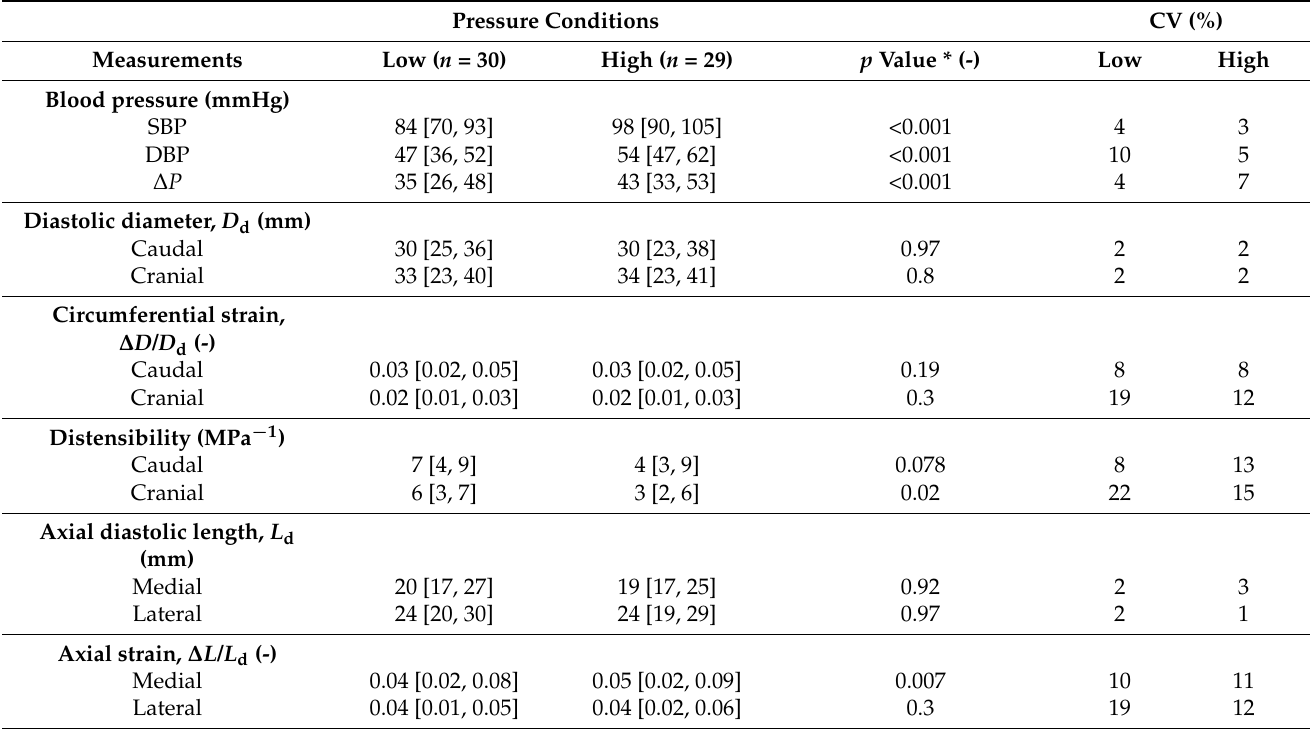
Table 2. Blood pressure and video-derived